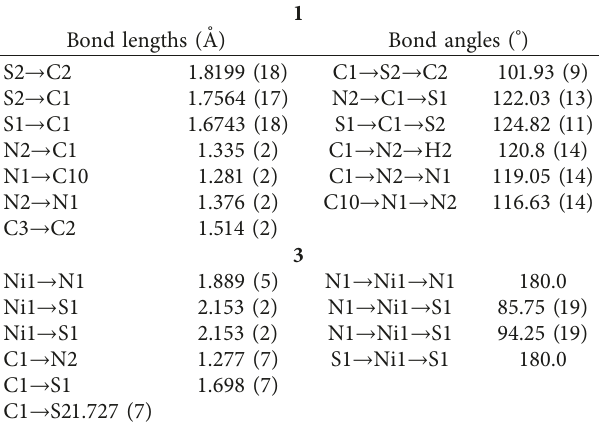
Figure 2: Frontier MOs of the Schiff base 1 and its complexes ( 2 – 4 Table 2: Selected bond lengths and bond angles of 1 and 3 .